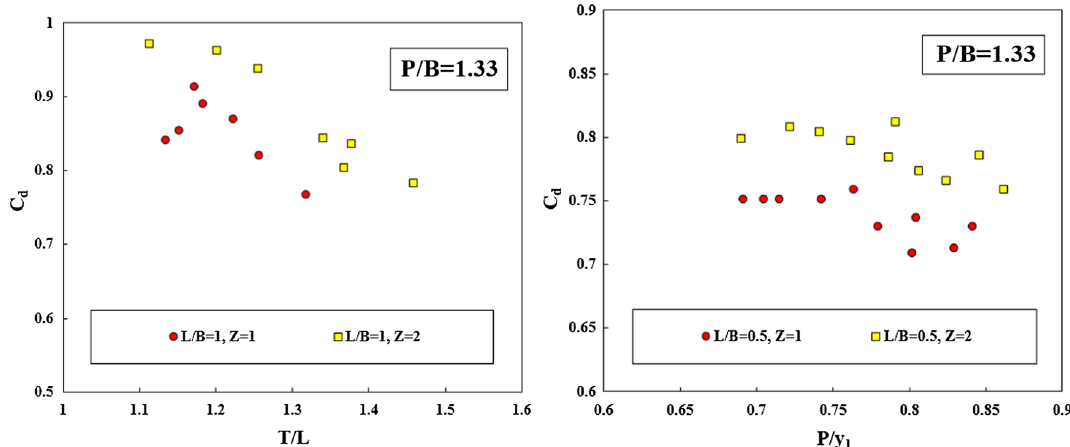
Fig. 9 Variations in discharge coefficient with P / y